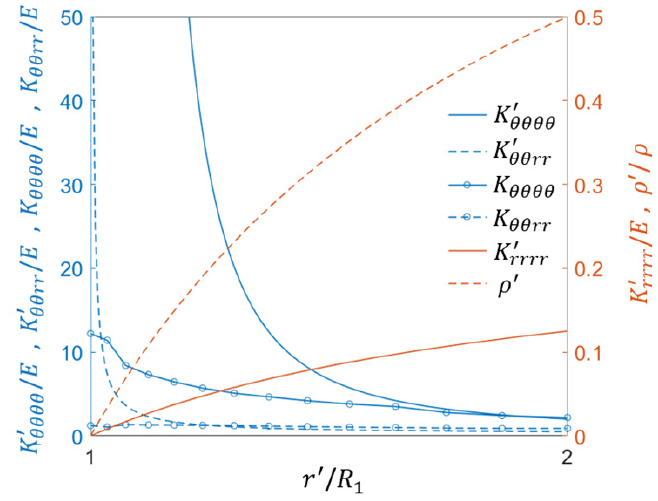
Figure 1. Change curves of material density and elastic matrix.